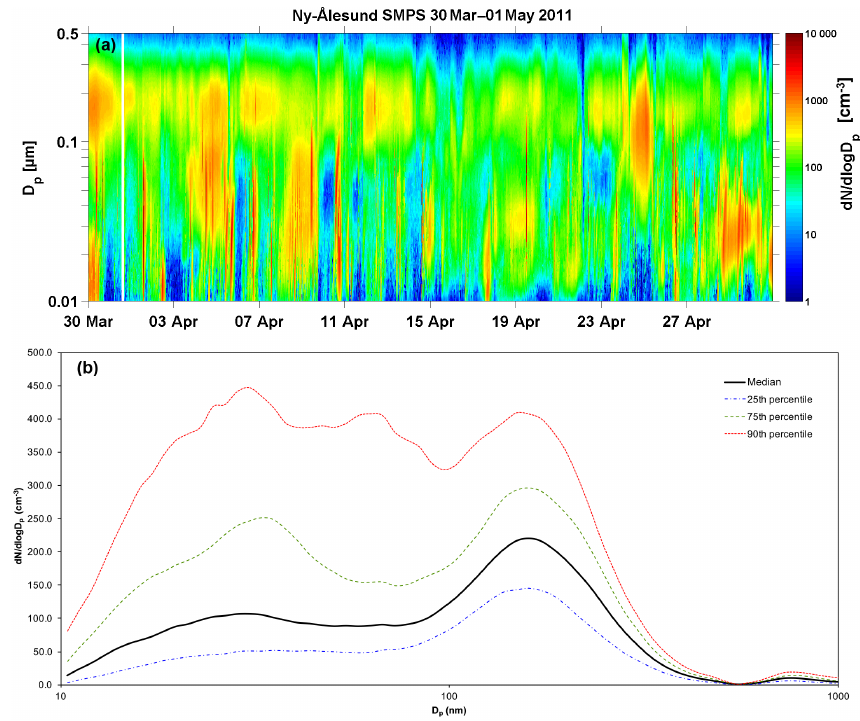
Figure 10. (a) Aerosol number size distribution measured at ground during April 2011; (b) 25, 50, 75 and 90th percentiles of the measured number size